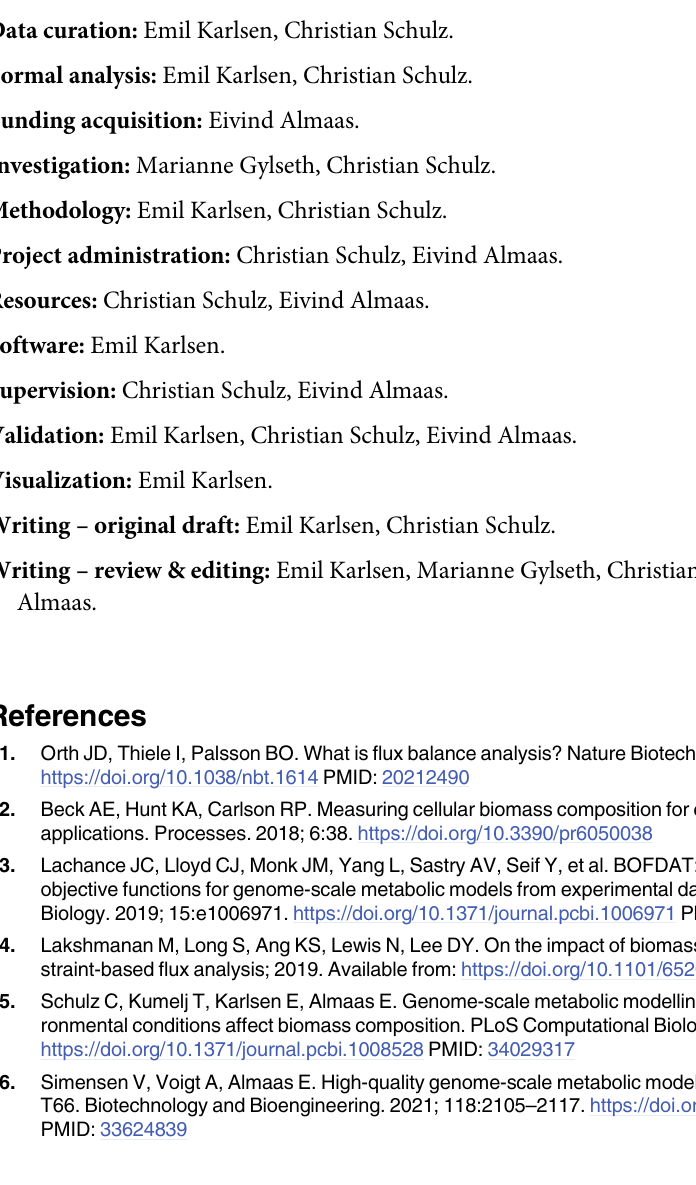
S2 File. Manual for the simulation program for Matlab. A PDF manual containing specifica- tions and user instructions for the fermentation simulation program written in